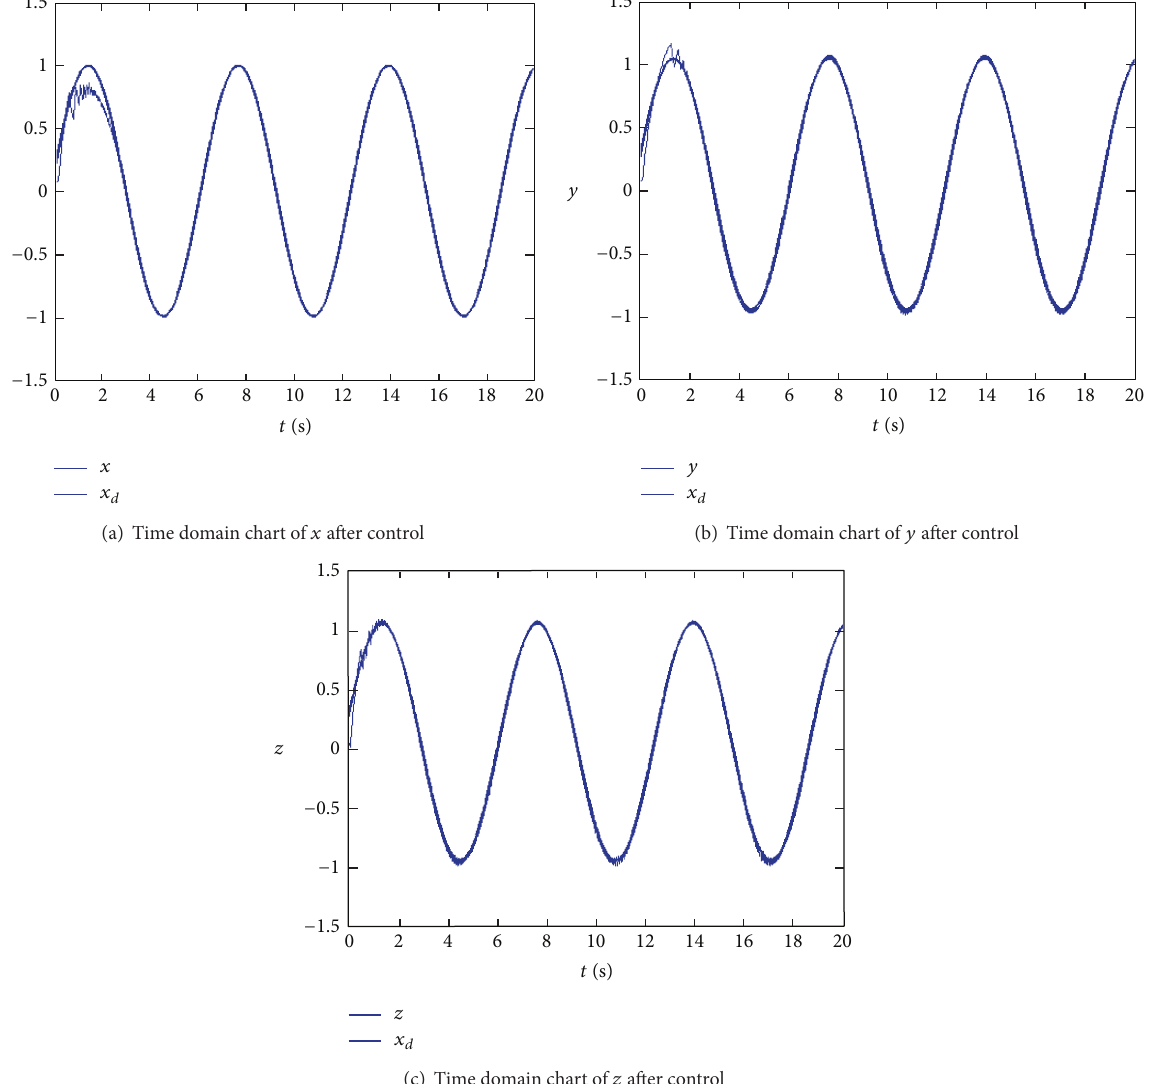
Figure 14: Time domain charts of state variables after